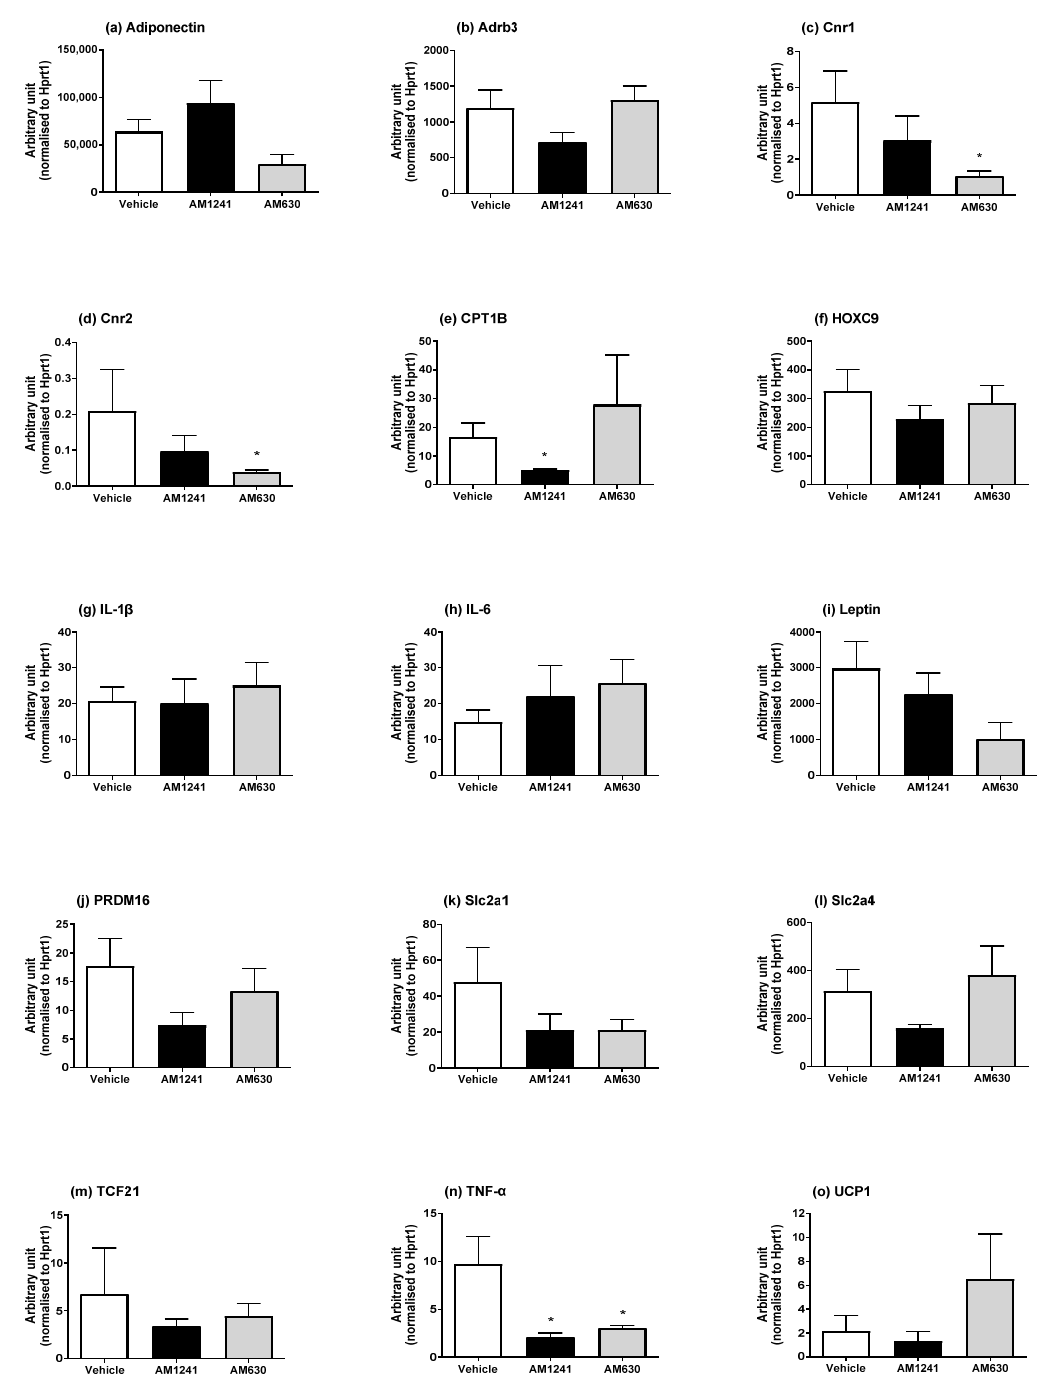
Figure 3. Effect of AM1241 or AM630 treatment on DIO rats peri-renal WAT mRNA expression. DIO rats were injected daily with either AM1241 (3 mg/kg of body weight, ip), AM630 (0.3 mg/kg body weight, ip), or vehicle for six weeks. All results are presented as a mean ± SEM in arbitrary units (normalized to housekeeping gene HPRT1) from n = 6–8 (AM1241)-, n = 6–10 (AM630)-, and n = 8–10 (vehicle)-treated rats on an HFD (exception n = 5 for Slc2a1 and Tcf21 in AM1241 and UCP1 for AM630, n = 6 for Tcf21 vehicle). Significance * p < 0.05 compared to vehicle.